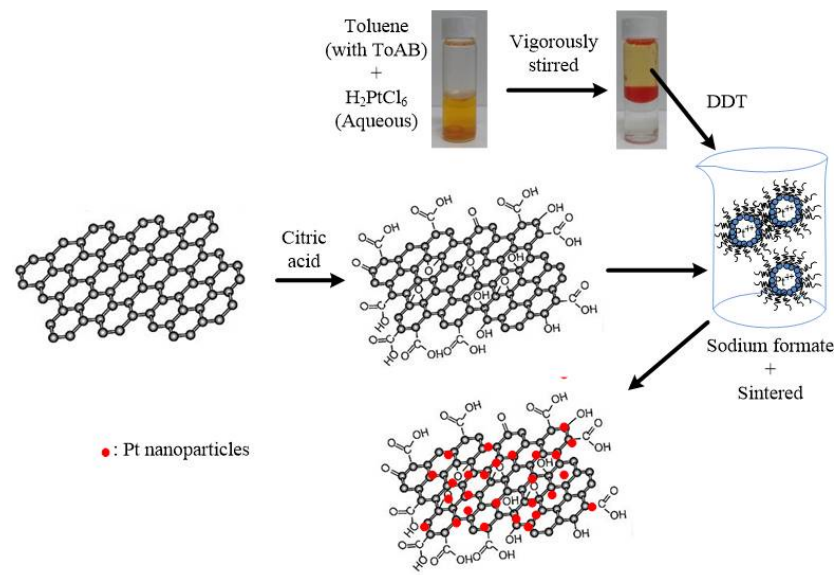
Figure 1. Schematic representation of surface modification of graphene sheets and the deposition of Pt nanoparticles.